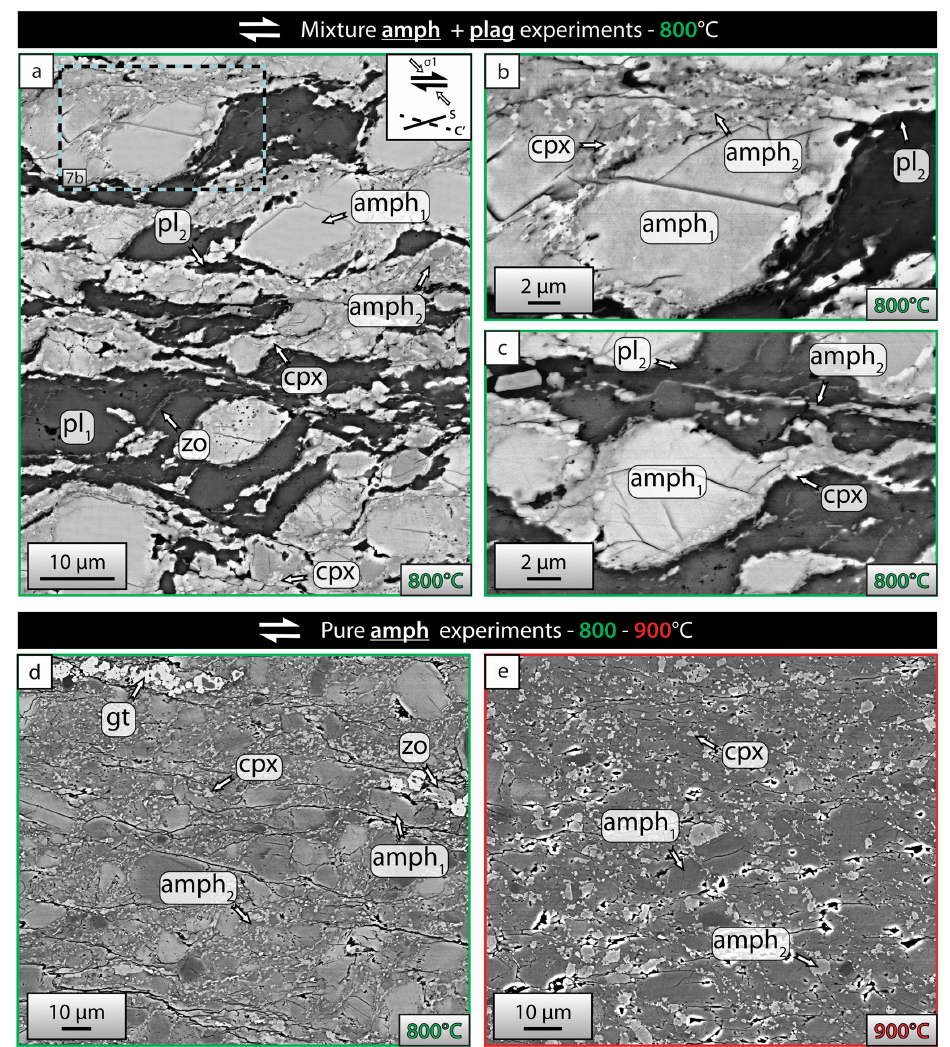
Figure 7. SEM BSE images representative of microstructures shown in deformed amph + plag and pure amph assemblages. (a, b, c) Nu- cleation of amph-rich layers in the amph + plag assemblage deformed at 800 ◦ C. (d–e) The pure amph assemblages deformed at 800 and 900 ◦ C show the development of fine-grained mixture zones of amph 2 and cpx. opx: orthopyroxene, cpx: clinopyroxene, pl: plagioclase, amph: amphibole, gt: garnet, zo: